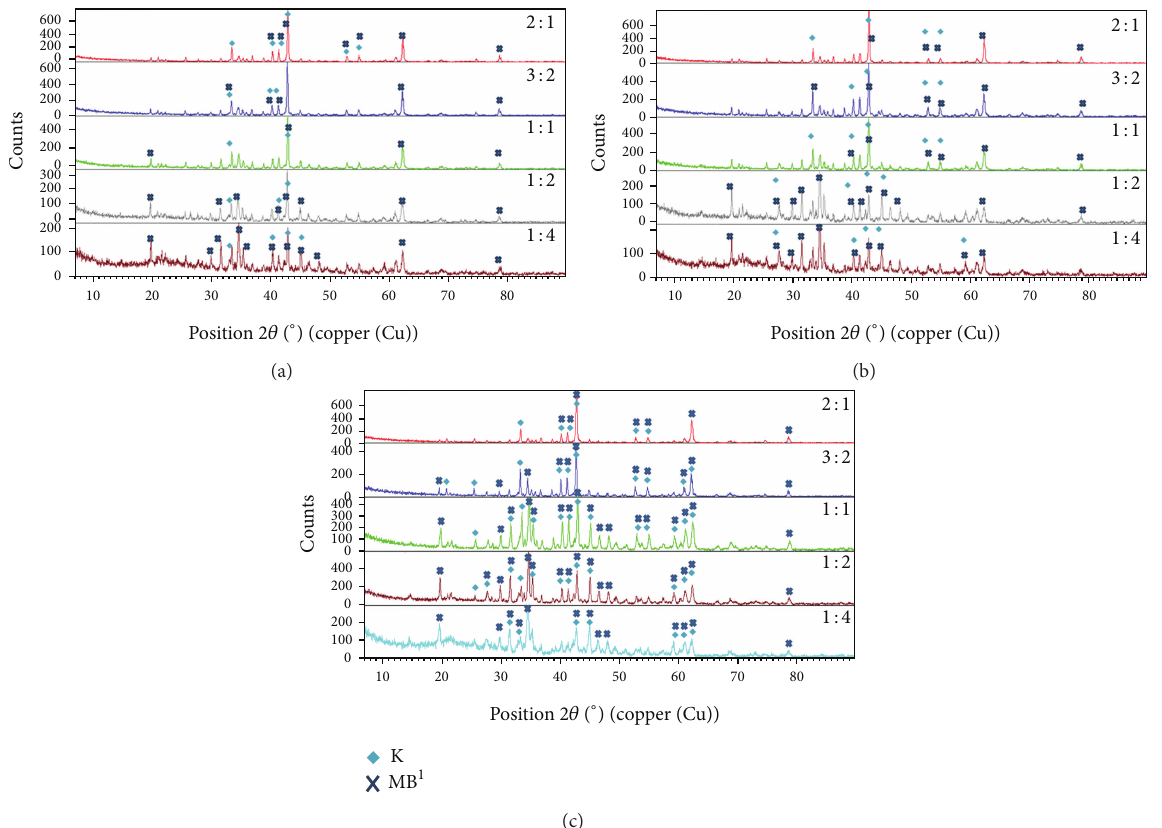
Figure 1: XRD patterns of the synthesized dehydrated magnesium borate minerals at 1000 ∘ C. (a) 30 minutes, (b) 60 minutes, and (c) 240